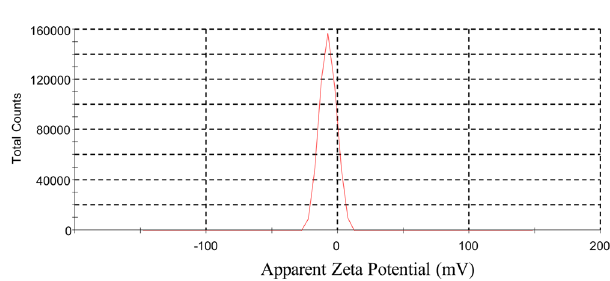
Figure 8. Zeta potential measurement of FGA-1 at 25 °C.